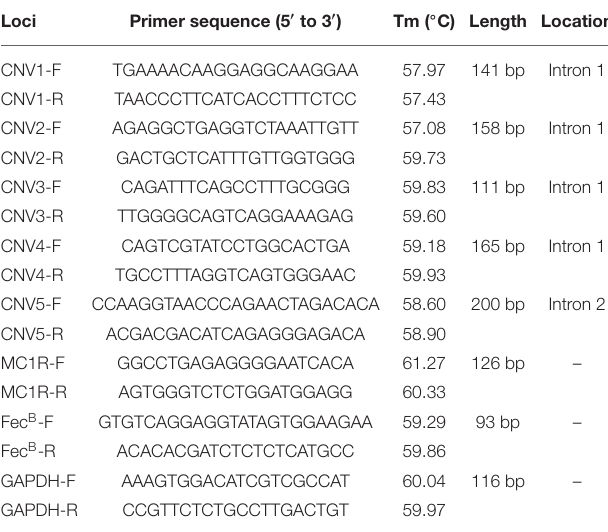
TABLE 1 | Information on the primers used in this study.